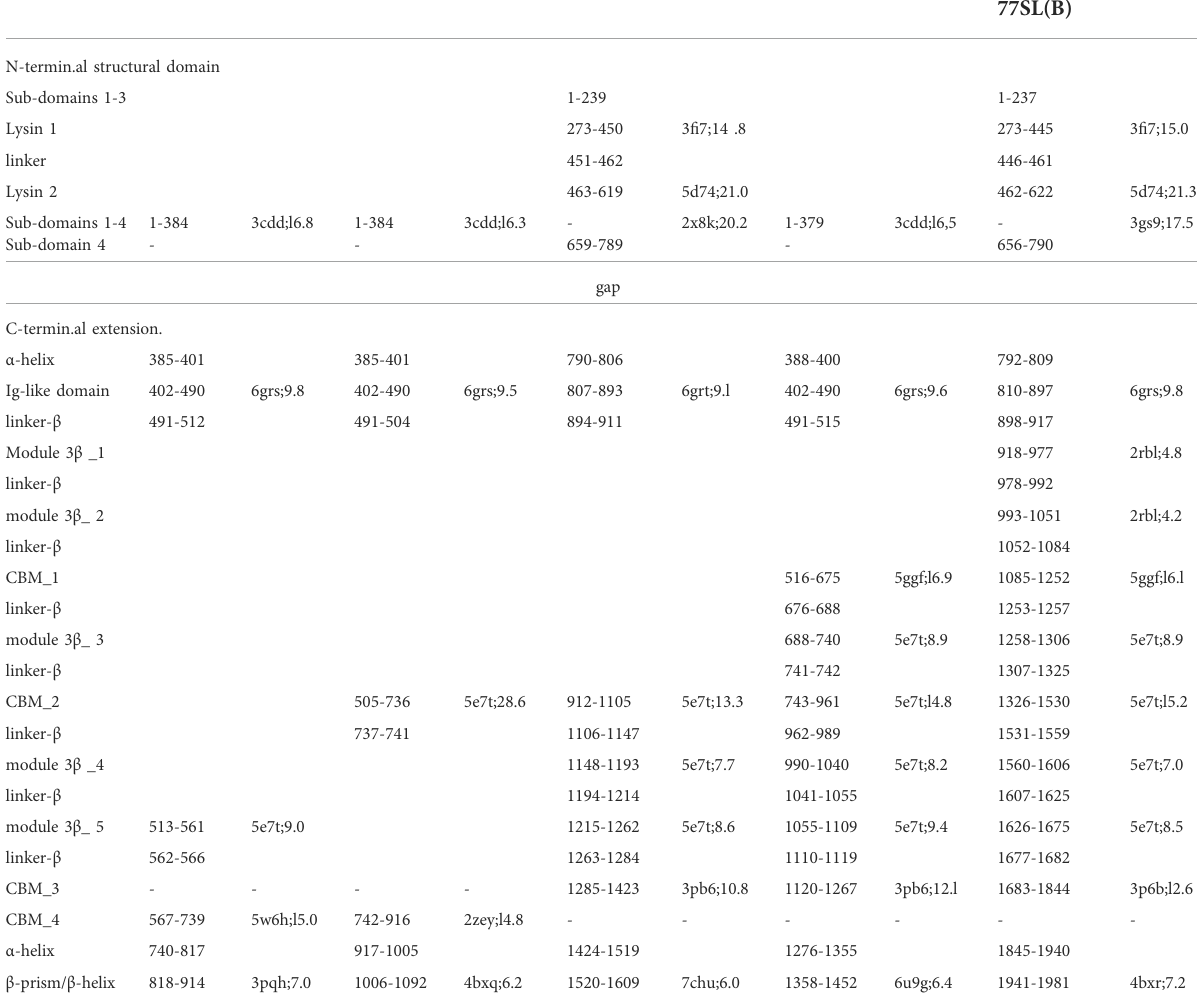
TABLE 1 Tai domain boundaries in predicted structures (M: Moineauvirus ; B: Brussowvirus ; § : PDB ID; Z